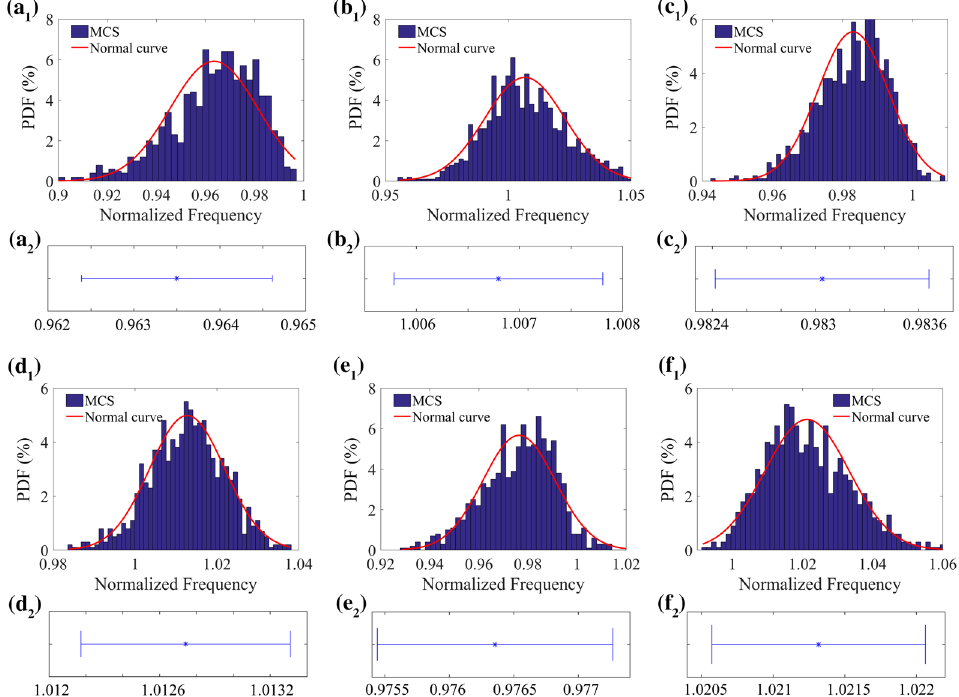
Figure 5 Probability density and the 95% confidence interval and mean of the first six frequencies for 1000 random samples about mistuned bolt distribution: a The first order; b the second order; c the third order; d the fourth order; e the fifth order; f the sixth order (subscript 1 represents the probability density, subscript 2 represents the 95% confidence interval and